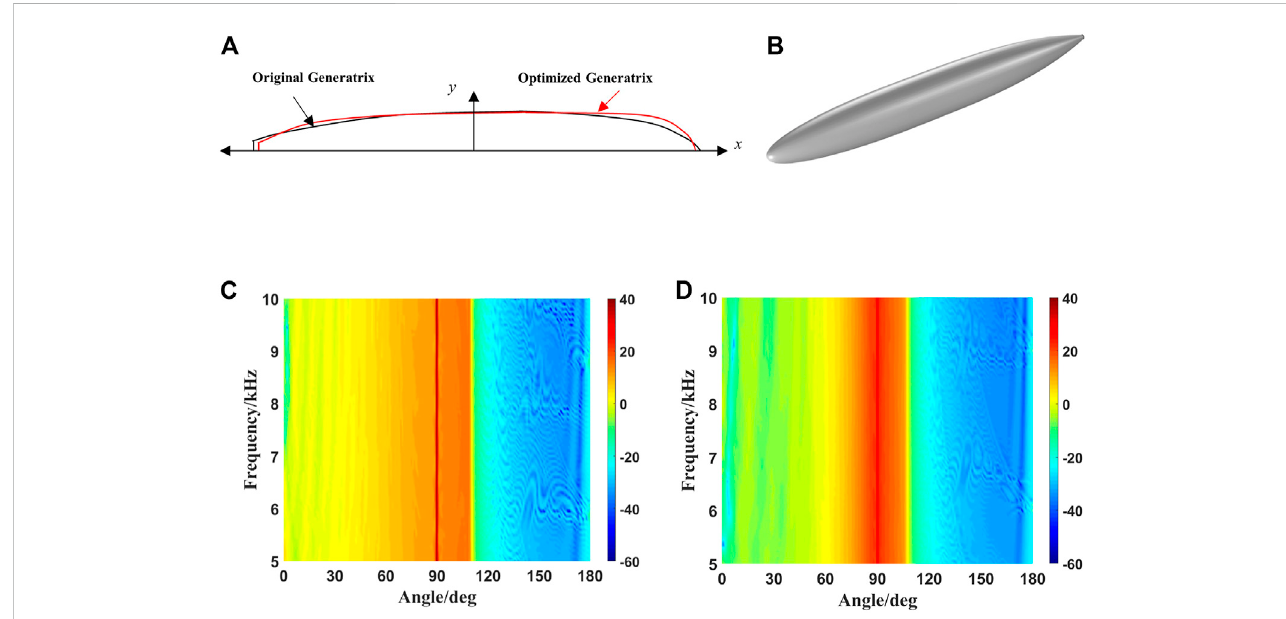
FIGURE 7 Comparisonofthehullgeneratricesbeforeandafteroptimizationandthree-dimensionaldiagramafteroptimization. (A) Frontandrearhullgeneratrices.